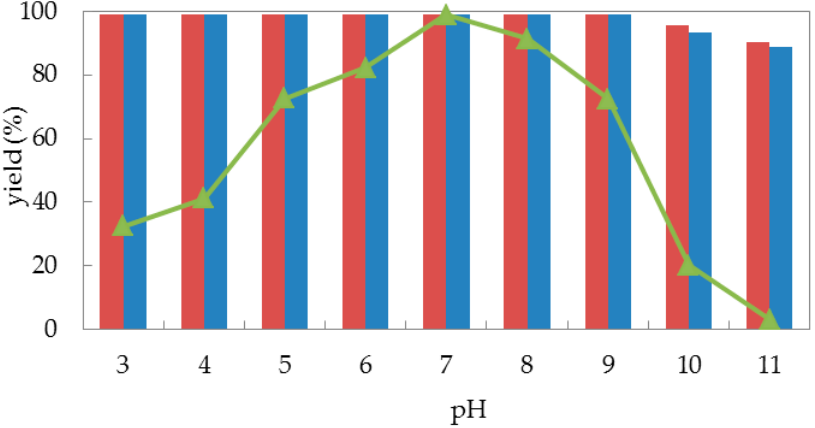
Figure 3. pH profile for free cells (represented by the triangles), immobilized cells on agar (represented by the red striped bar) and calcium alginate (represented by the blue striped bar) of G. candidum AS 2.361 catalyzing the reduction of 1-(2-bromophenyl) ethanone ( 1a